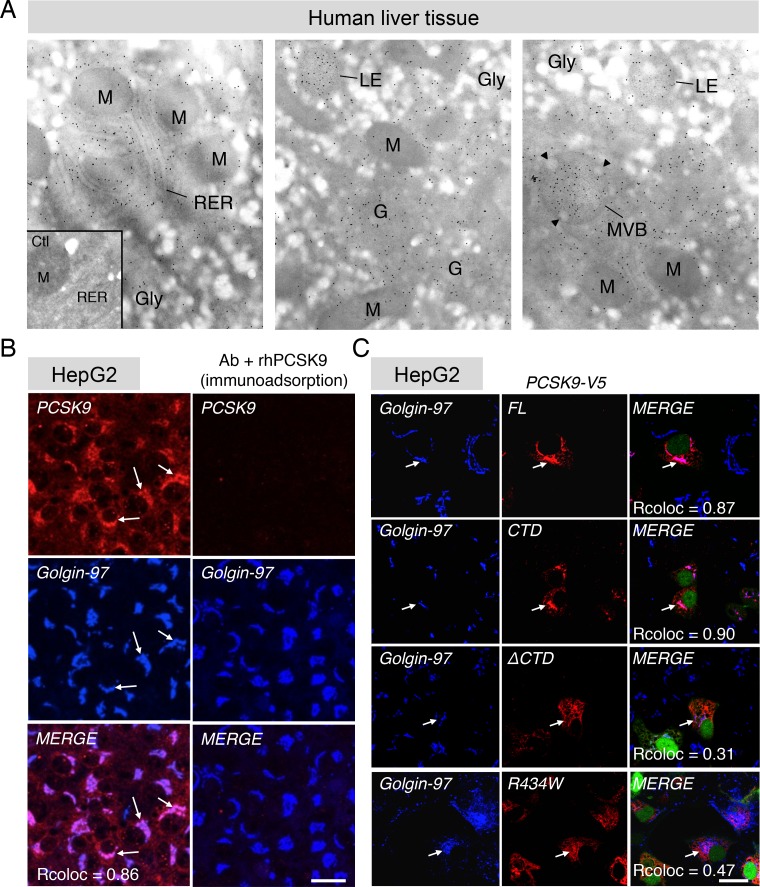
PCSK9 localizes at the TGN via its CTD.(A) Ultrastructural localization of PCSK9 in normal human liver tissue sections shows the immunogold labeling over the rough endoplasmic reticulum (RER; left panel), Golgi apparatus (G), mulitvesicular bodies (MVB) and late endosomes (LE) (middle and left panels) of hepatocytes. Arrowheads denotes inward budding vesicles that are characteristic of MVBs (right panel). Note the presence of very few gold particles over mitochondria (M) and glycogen (Gly) indicating the specificity of the labeling. Omission of the primary antibody resulted in the absence of specific labeling (control experiment, Ctl; inset). Magnification X 25000. (B) Co-localization of endogenous PCSK9 with the TGN marker Golgin-97 as visualized by confocal microscopy (left panels, white arrows). Specificity of PCSK9 immunolabeling was tested following overnight pre-incubation of the anti-PCSK9 Ab with 1 μg/ml recombinant human PCSK9 (right panels, immunoadsorption). (C) HepG2 cells were transfected with V5-tagged FL PCSK9, CTD, ΔCTD or LOF R434W mutant and co-localization with Golgin-97 was analyzed by confocal microscopy. (B, C) Colocalization was quantified using Pearson’s correlation coefficient (Rcoloc) (minimum of 10 cells were analyzed). Data are representative of at least three independent experiments. Scale bars, 20 μm.